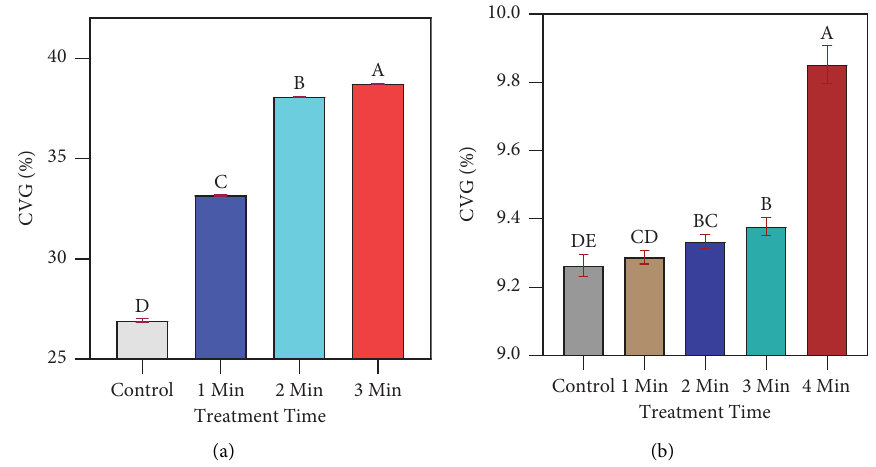
Figure 10: Infuence of CAPP treatment on the CVG of (a) radish and (b) carrot.